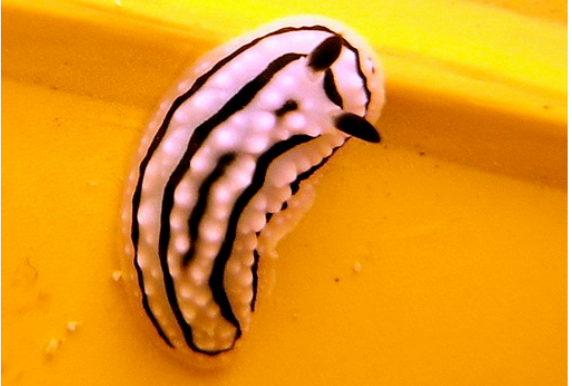
Image 1. The reported individual ( Phyllidiella zeylanica